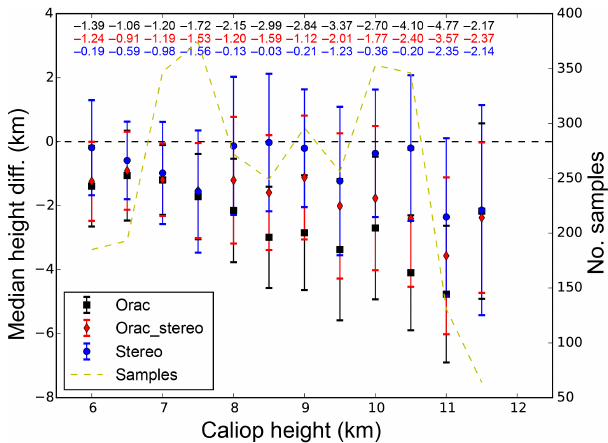
Figure 8. Error bar plot plotting the median height differences for multi-layer ice clouds (over water where ORAC and ORAC + stereo phase agrees) at or above 6km (as determined by the uppermost CALIOP CTL elevation) for the three algorithms applied to AATSR and the elevation of the uppermost CALIOP CTL, as a func- tion of the elevation of the uppermost CALIOP CTL at 500m intervals (in this instance the median is derived from all collo- cated data contained within set given by the uppermost CALIOP CTL elevation indicated on the x axis and all uppermost CALIOP CTL samples which are located within the following 500m, e.g. 6km ≤ CTL<6.5km). The three statistics above each error bar are the median differences. The error-bar whiskers represent 1 standard